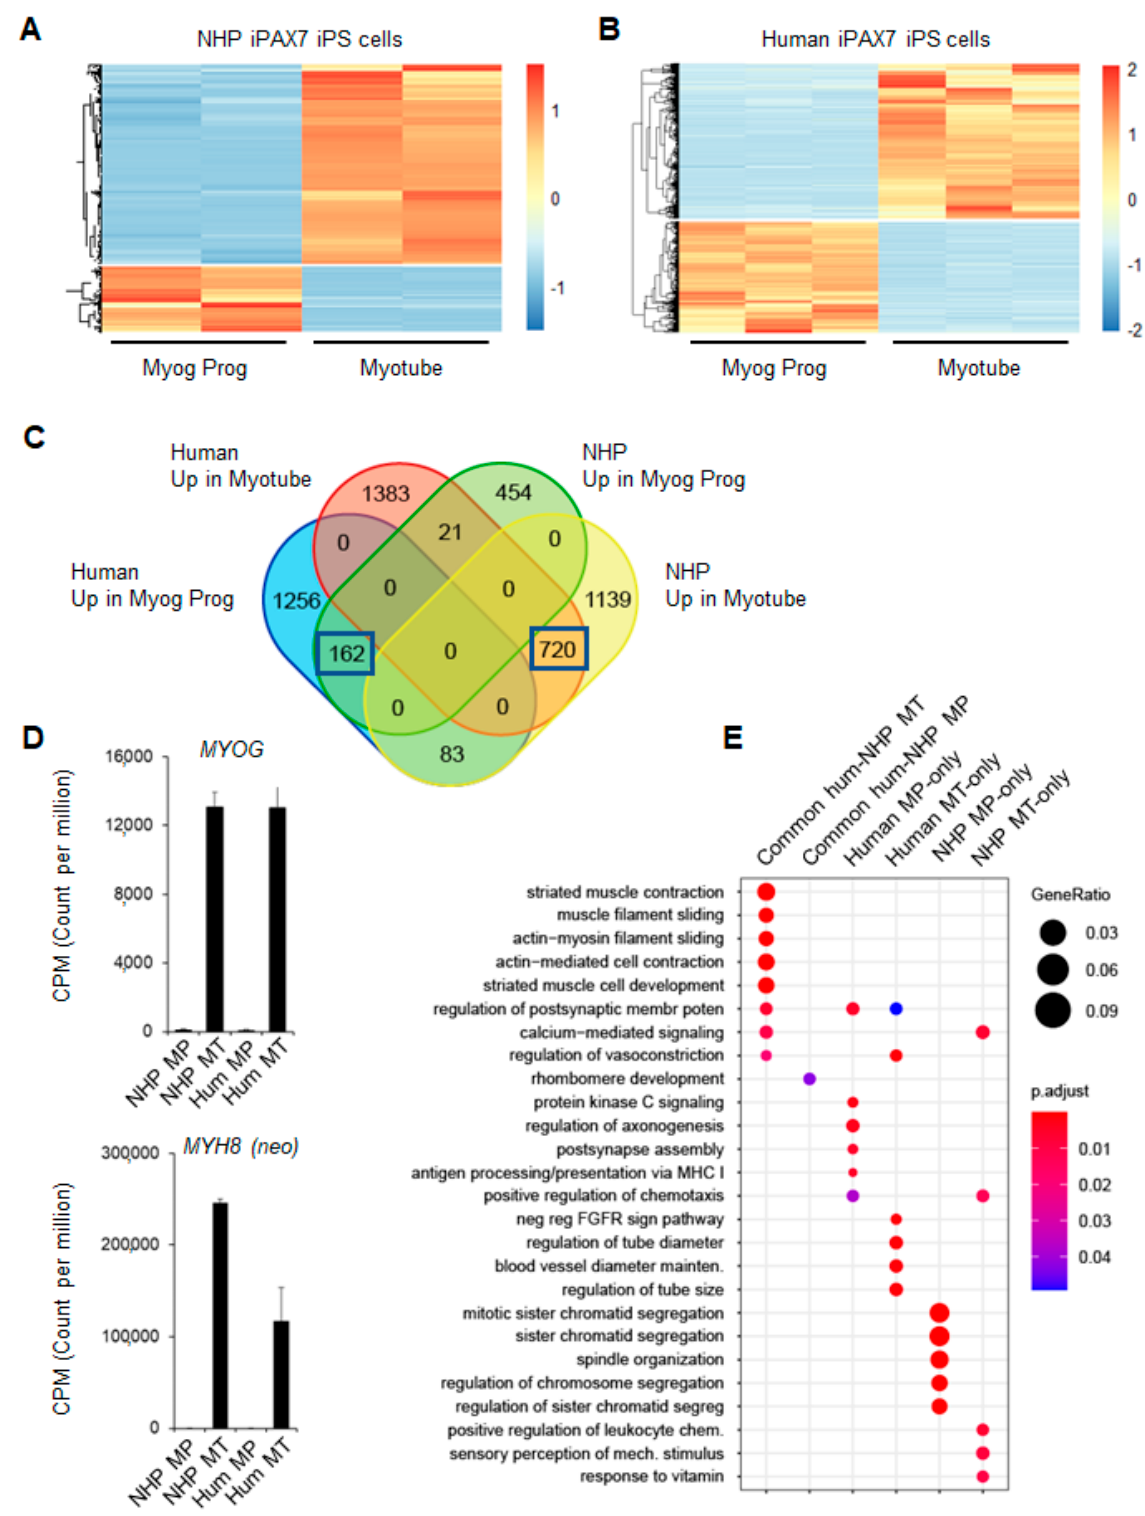
Figure 3. Comparison of NHP and human myogenesis shows high similarity in vitro : ( A , B ) Heatmap representing differentially expressed transcripts between myogenic progenitors (Myog Prog) and myotubes (Myotube) derived from NHP and human iPAX7 iPS cell cultures, respectively;